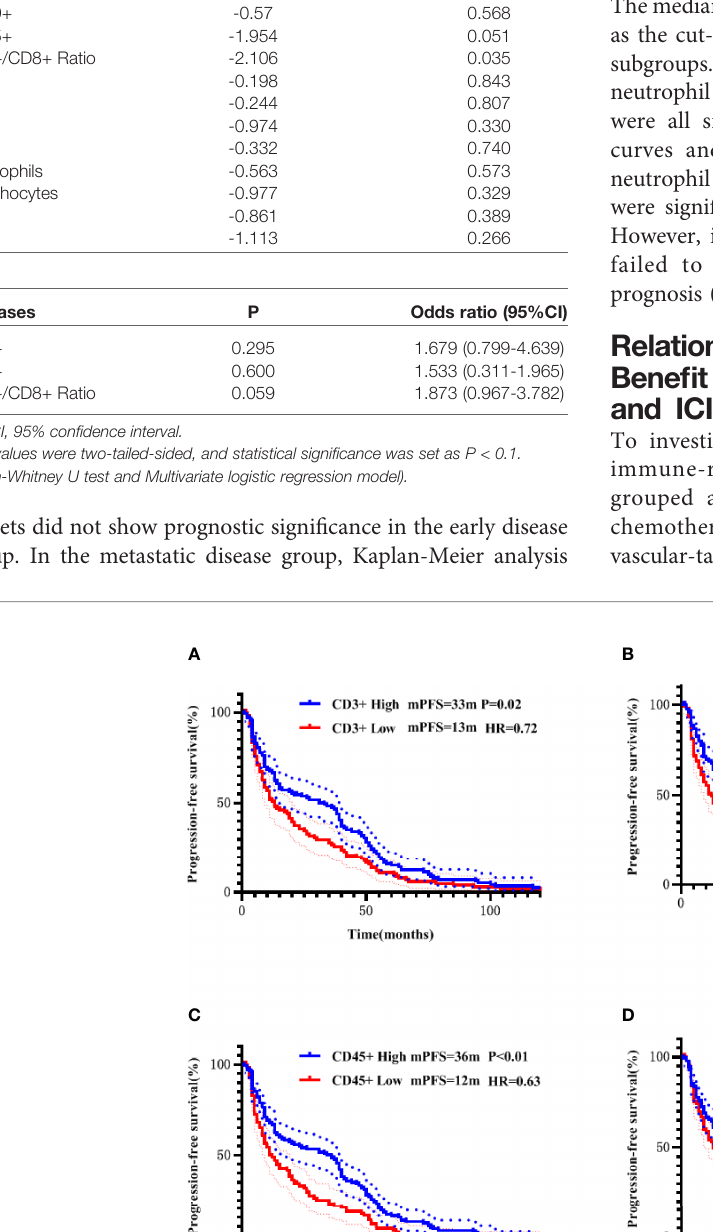
FIGURE 3 | Correlation of CD3+ (A) , CD4+ (B) , CD45+ (C) , and CD56+ (D) with PFS addressed by the Kaplan-Meier method and log-rank